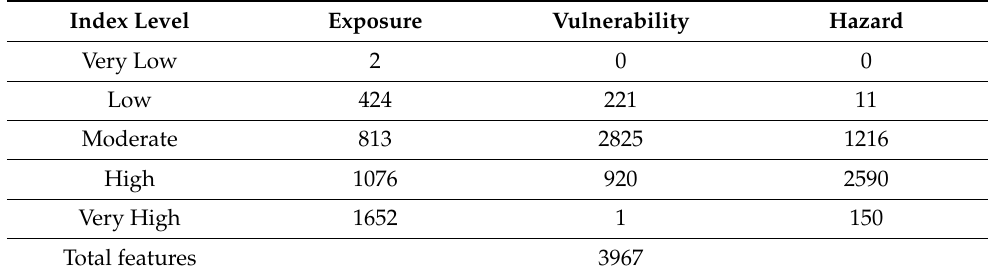
Table A4. Feature count of computed building exposure, vulnerability, and hazard index